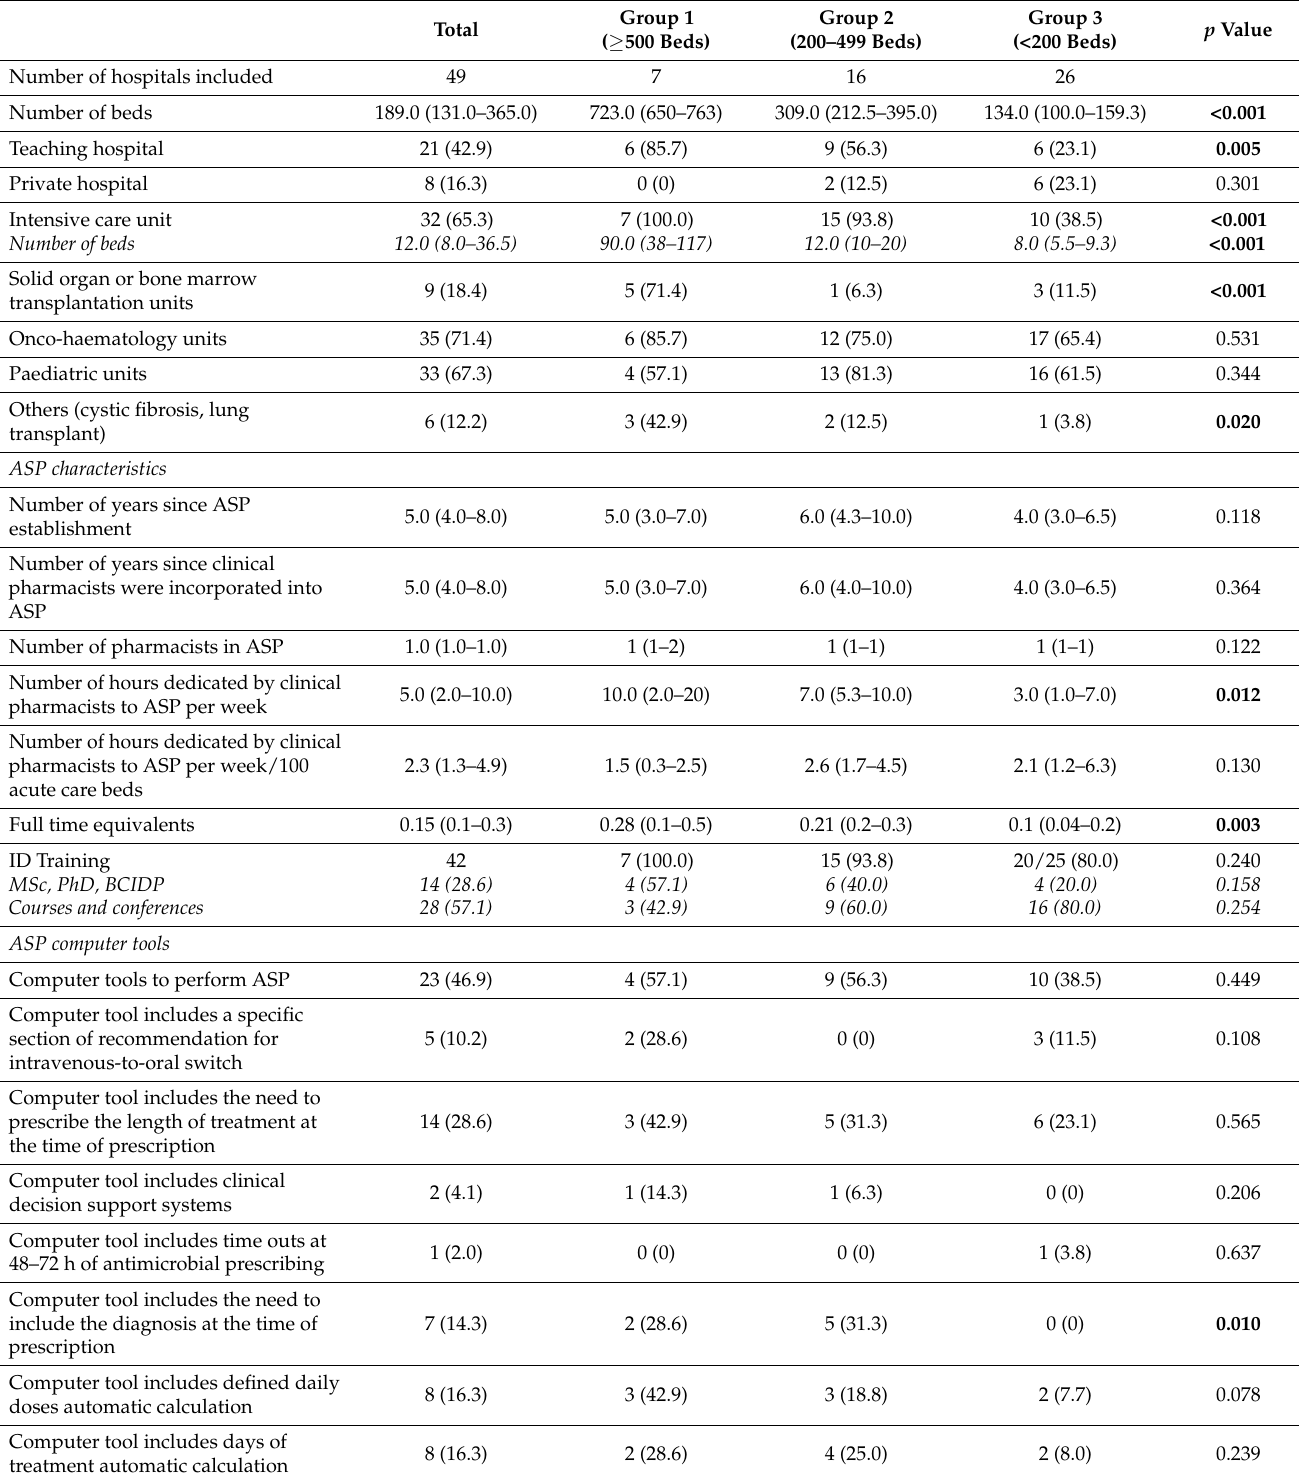
Table 1. Characteristics of hospitals and available computer tools of antimicrobial stewardship